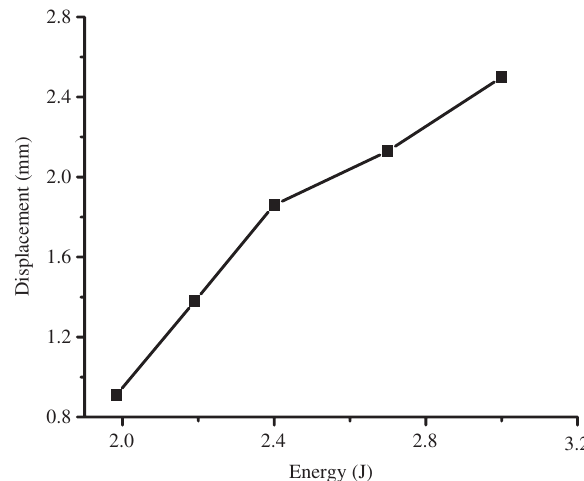
Figure 16: The curve between the impact energy and damage area of the adhesive layer and displacement at the plate center.